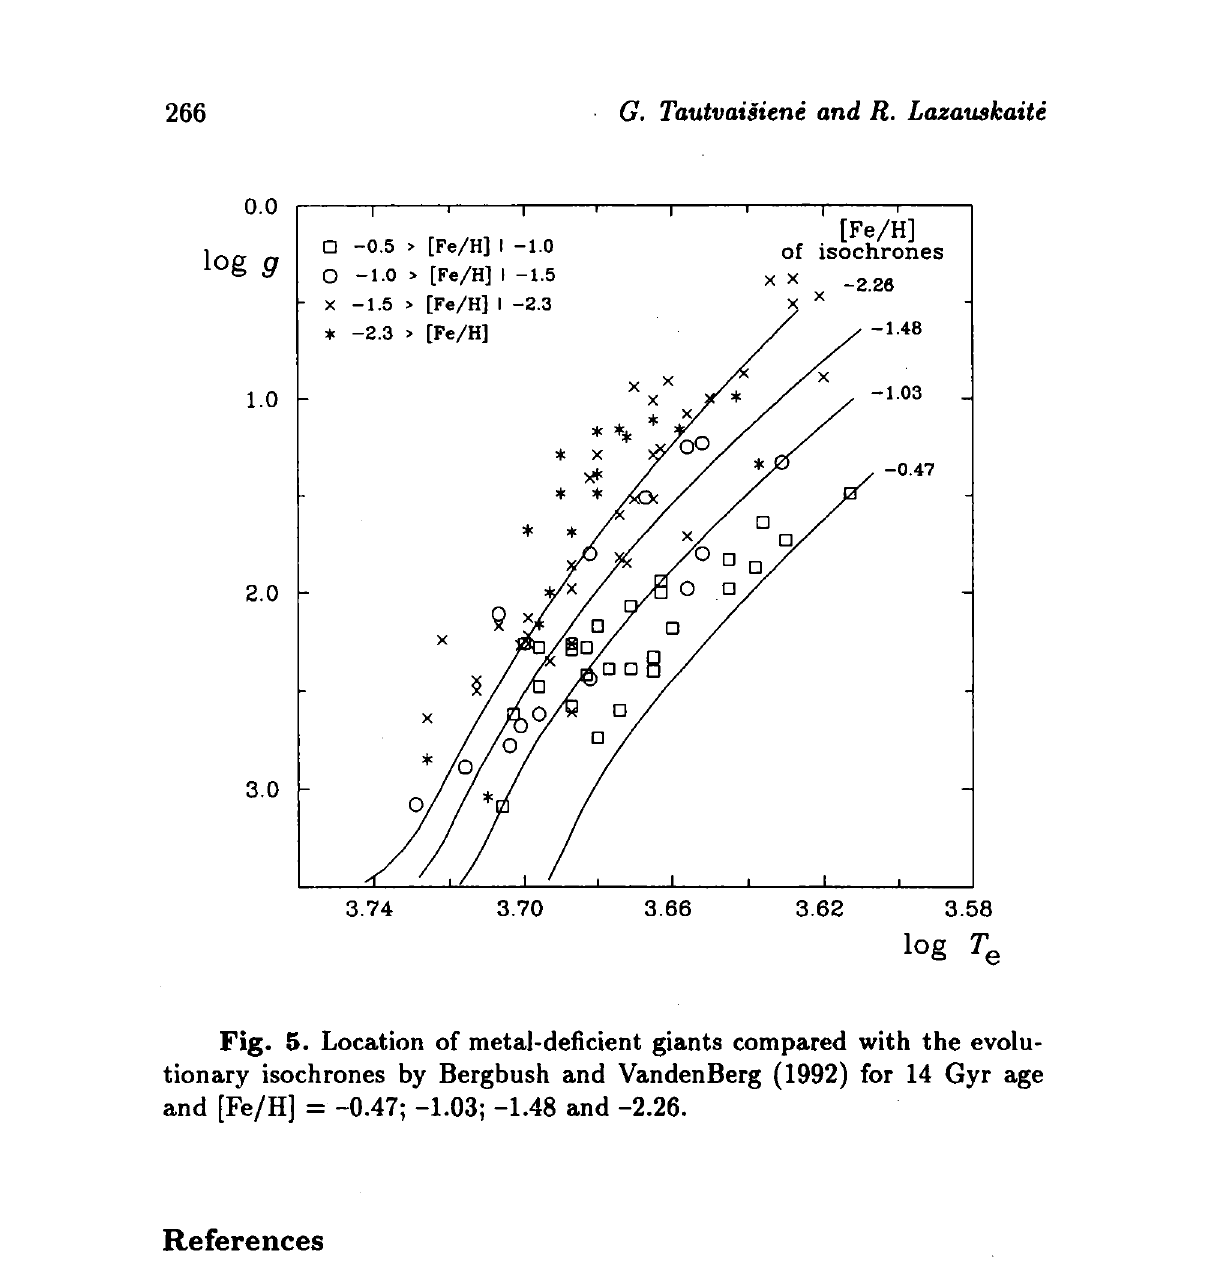
Fig. 5. Location of metal-deficient giants compared with the evolu- tionary isochrones by Bergbush and VandenBerg (1992) for 14 Gyr age and [Fe/H] = -0.47; -1.03; -1.48 and